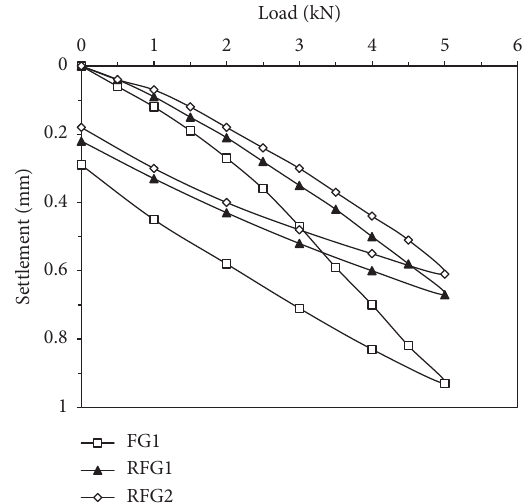
Figure 6: Load-settlement curves of GRPS composite foundations under static loads.